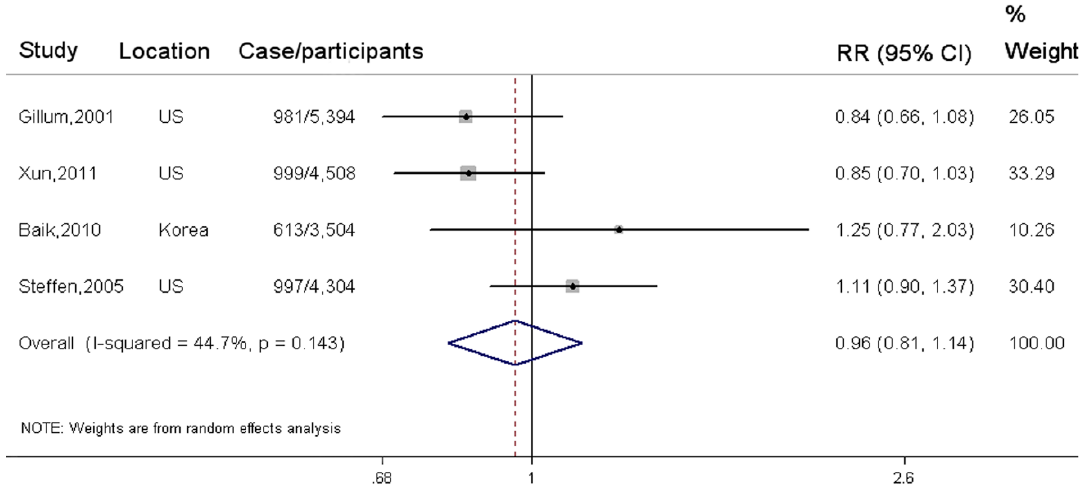
Figure 2. Associations between fish consumption and incidence of elevated BP in the highest verse the lowest exposure category.